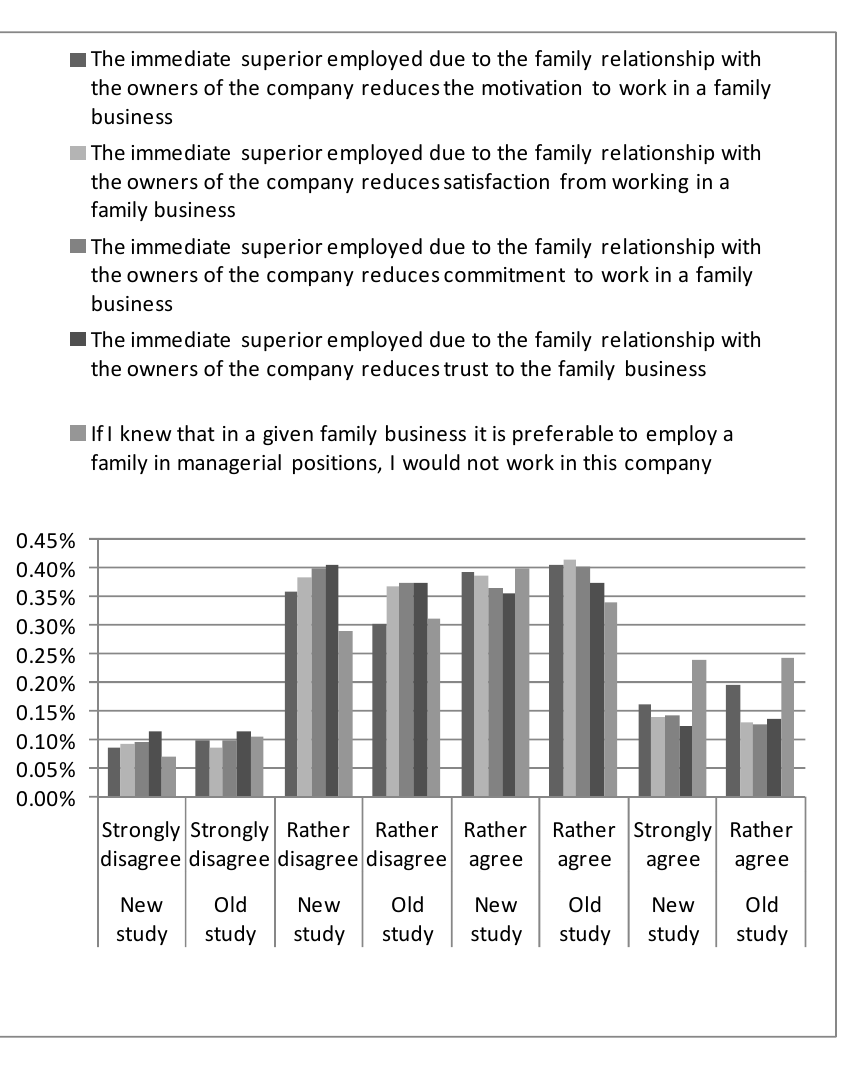
Figure 4. The impact of nepotism on employees in a family business. Source: authors’ own elabo- ration.